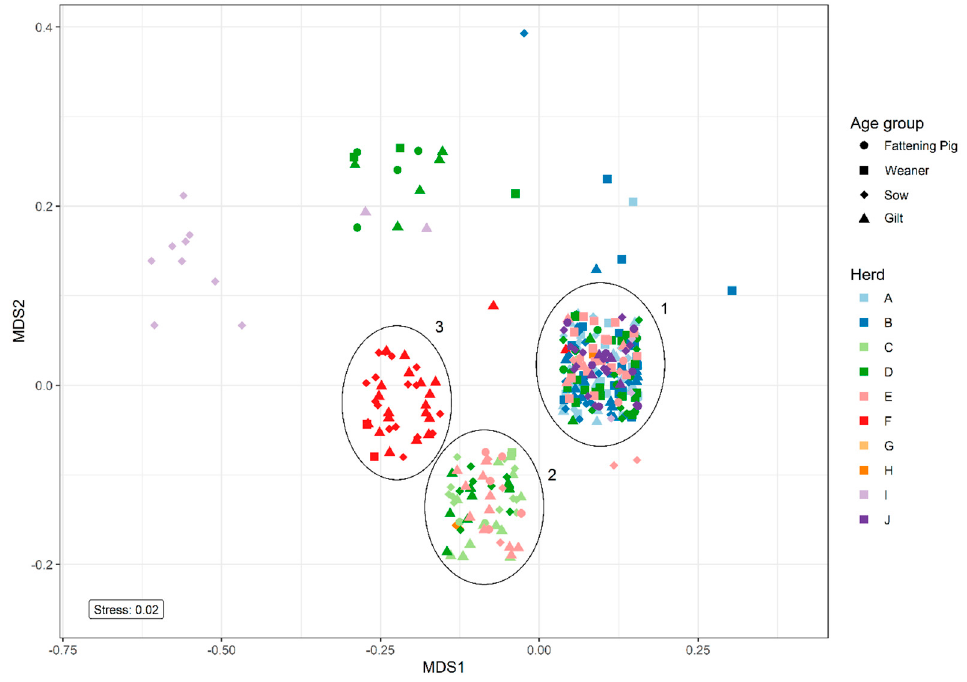
Figure 3. Non-metric multidimensional scaling (NMDS) analysis of resistance patterns among the 338 QREC isolates, colour-separated by herd. The shapes represent the age group of the animal. Pairwise Jaccard distances between isolates were calculated based on the presence (1) or absence (0) of resistance towards 13 different antimicrobials. The NMDS analysis was run with two dimensions and 200 random starts. The points are jittered for easier interpretation. Rings denote major clusters with the following resistance patterns: Cluster 1: ciprofloxacin and nalidixic acid, Cluster 2: tetracycline, ciprofloxacin and nalidixic acid, Cluster 3: sulfamethoxazole, tetracycline, ciprofloxacin, and nalidixic acid.